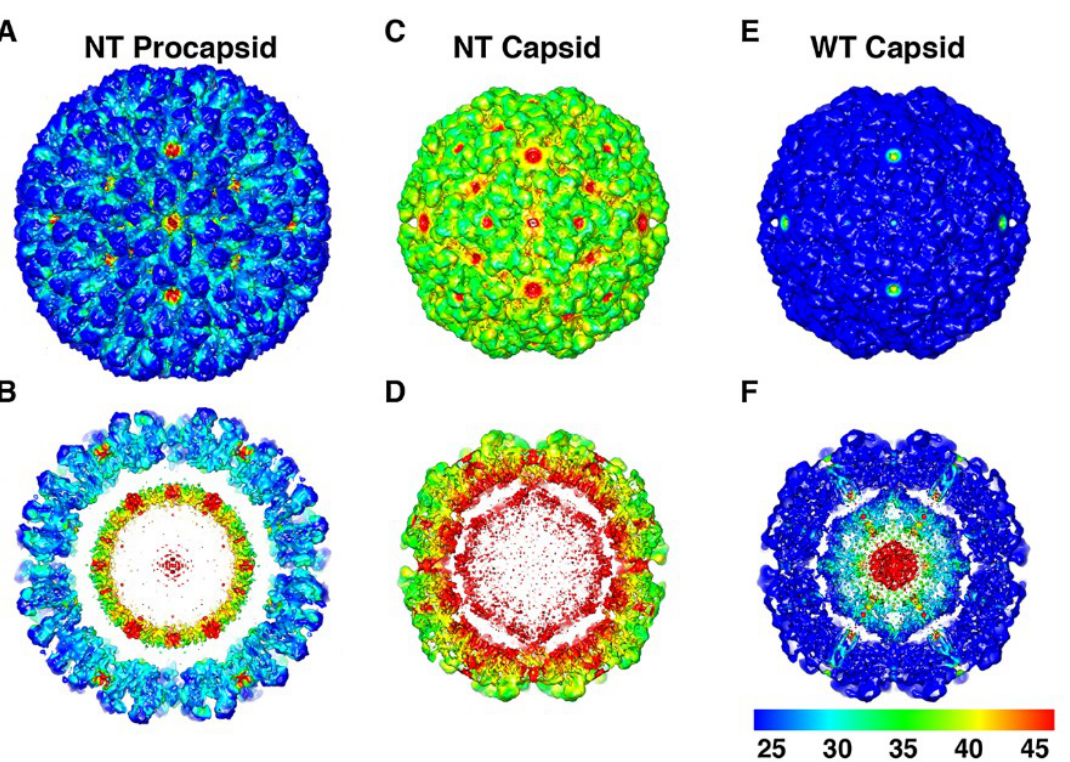
Figure 9. The structural fluctuations of the NωV particles plotted as standard deviation maps. Panels ( A , C , E ) are surface views of the cryoEM density maps of the NT procapsid, NT capsid, and WT mature capsid, viewed along an icosahedral 2-fold axis of symmetry and color coded according to values of their normalized standard deviation. The non-cleaving NT capsid and the mature cleaved WT capsid exhibit the highest and lowest standard deviations, respectively, and the NT procapsid is intermediate to these two. Panels ( B , D , F ) are the same as ( A , C , E ) but with the front halves of the density maps removed to reveal the standard deviation values for the internal features of the three particles. Reproduced with permission from Tang et al .